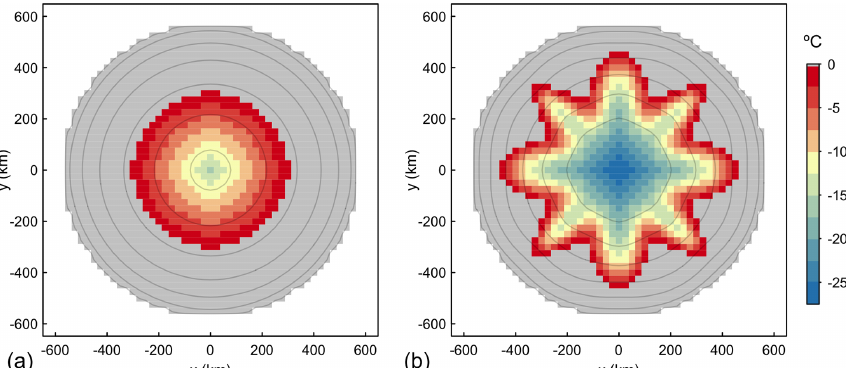
Figure 7. Steady-state, basal homologous temperature ( ◦ C) distribution after 100kyr obtained by Yelmo in EISMINT2 (a) experiment A and (b) experiment F. Areas that have reached the pressure-melting point have been shaded grey. The contour lines represent ice thickness at 500m intervals up to